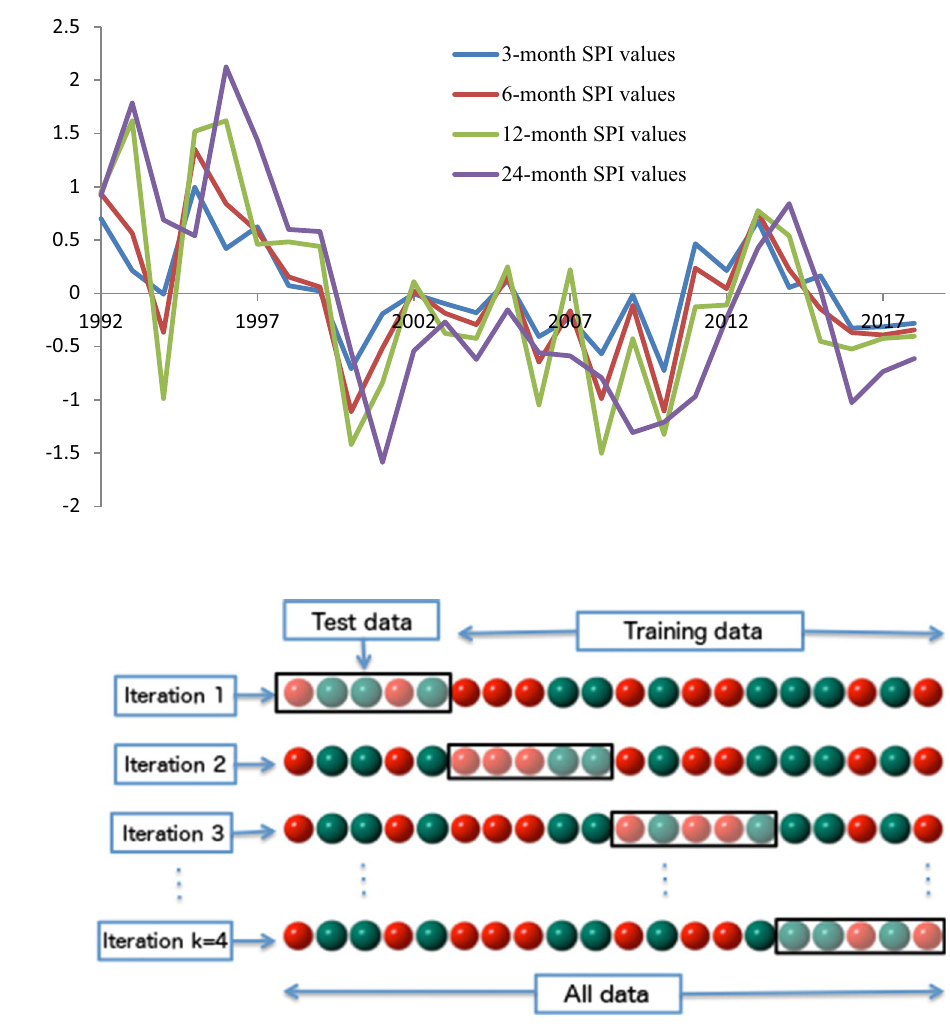
Fig. 5, the values of k = 15, 17 and 18 have the same lowest error rate. The K value of 18 has been selected for the Fuzzy - larger k values can often minimize risk of overfitting.